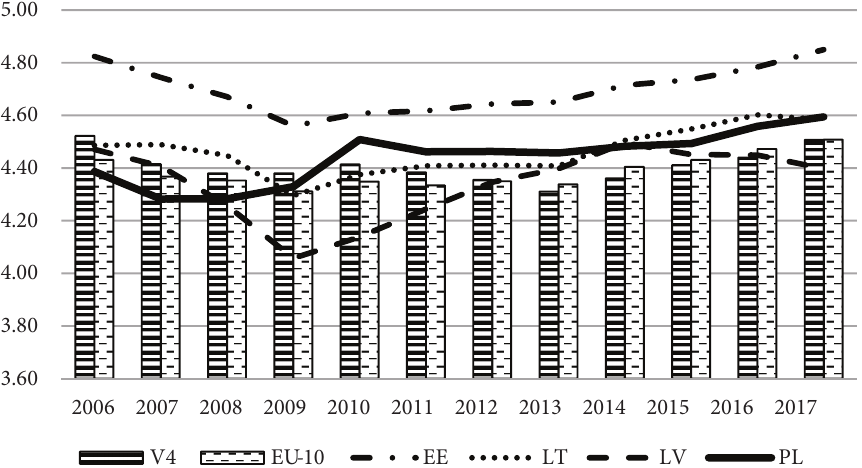
Figure 2. Competitive indices of the Baltic States against the backdrop of Poland, the V4 coun- tries and the EU-10 in 2006–2017 (source: own study based on data as in Table